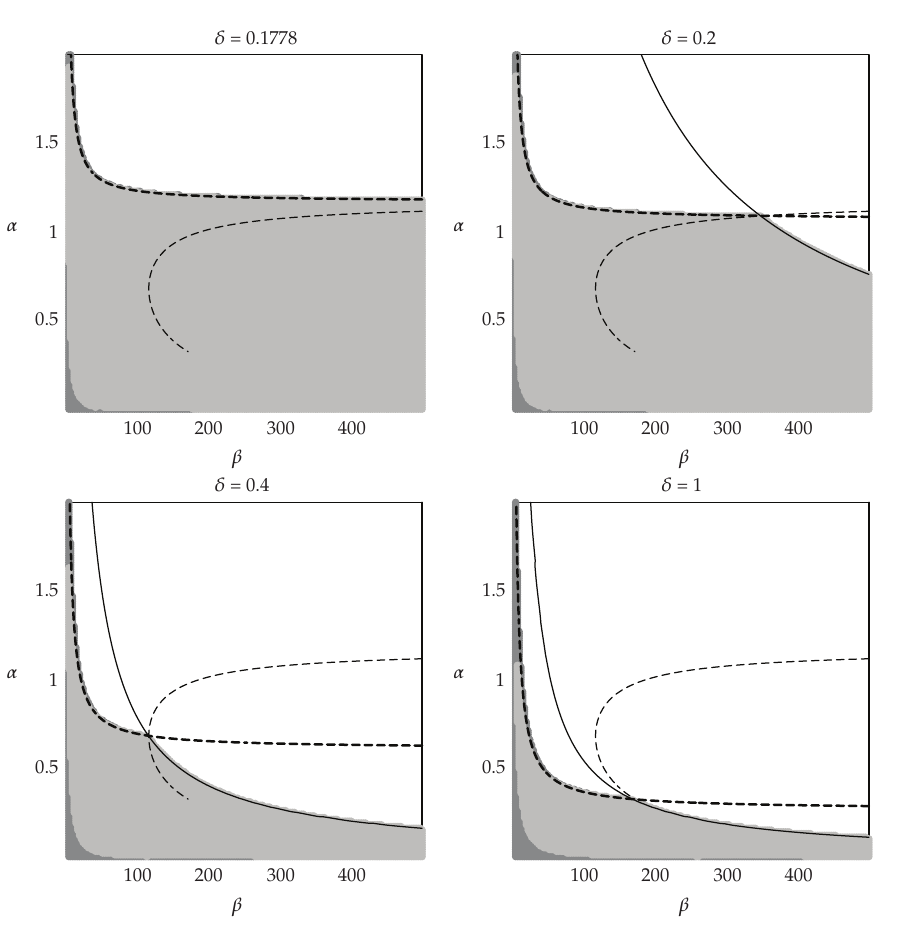
Figure 13: Regions of stability for Z (cid:9) 35, γ (cid:9) 1 . 2